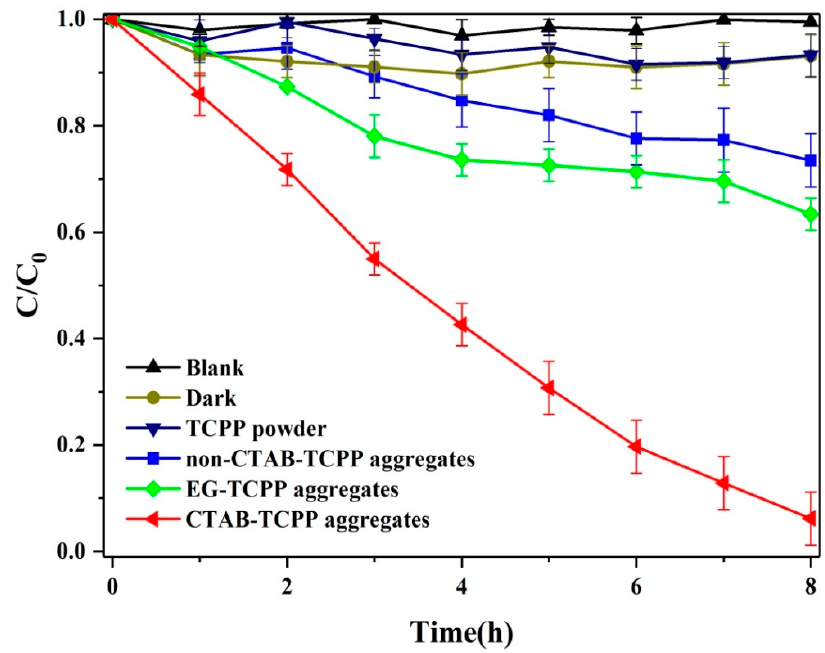
Figure 5. Degradation rates of phenol by different TCPP aggregates under visible light.